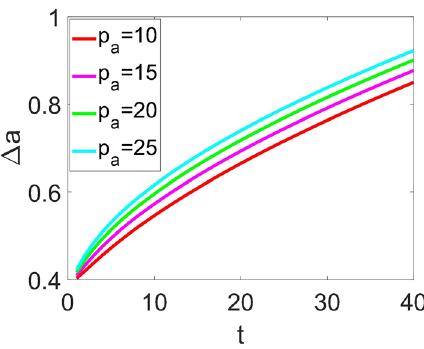
Fig. 6 Variations in the variance. The horizontal and vertical axes rep- resent the time variable and variance, respectively. The parameters are taken as: α = 0 . 5, V 0 = 200